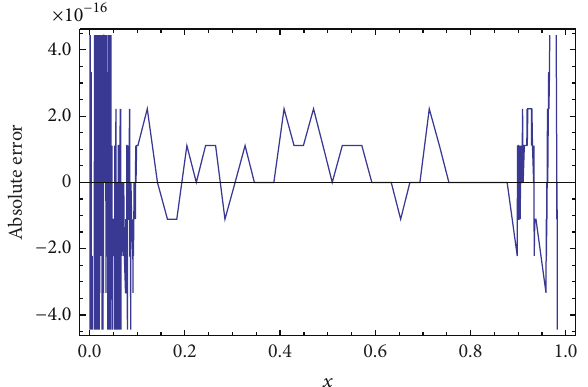
Figure 1: Plots of the solution ] (𝑟) for the radial Yamabe equation obtained by the present method for 𝜆 = 0.5 , 0.33, 0.25, 0.20, 0.16, 𝑛 = 3/2 , and 𝜃 = 𝜗 = 1 at 𝑁 = 8 .